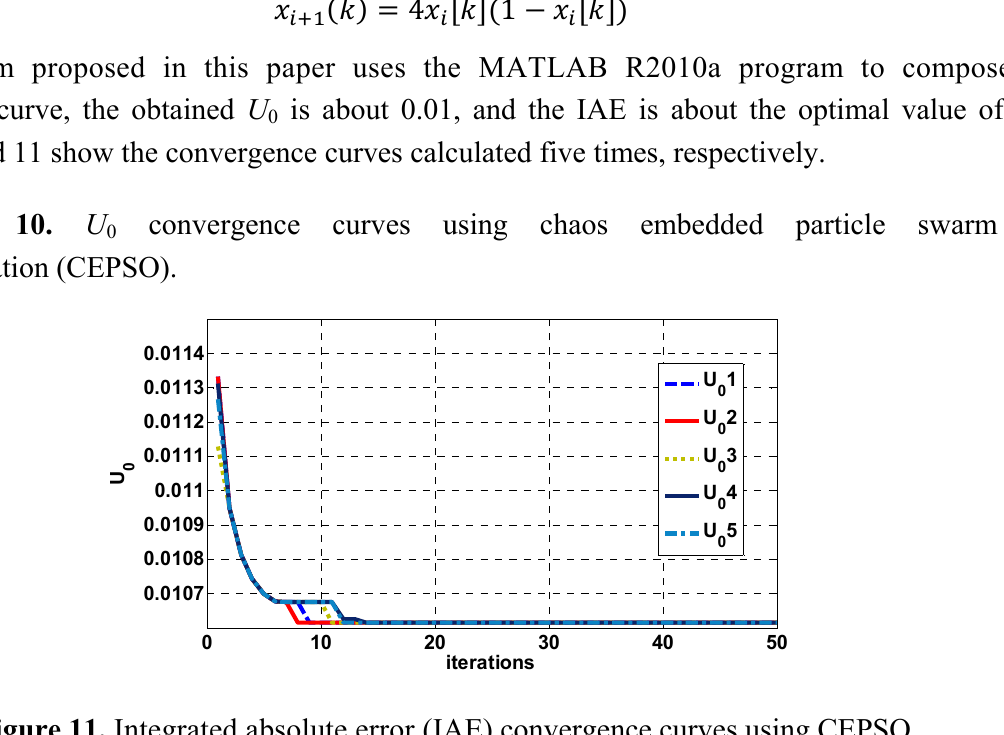
Figure 11. Integrated absolute error (IAE) convergence curves using CEPSO.